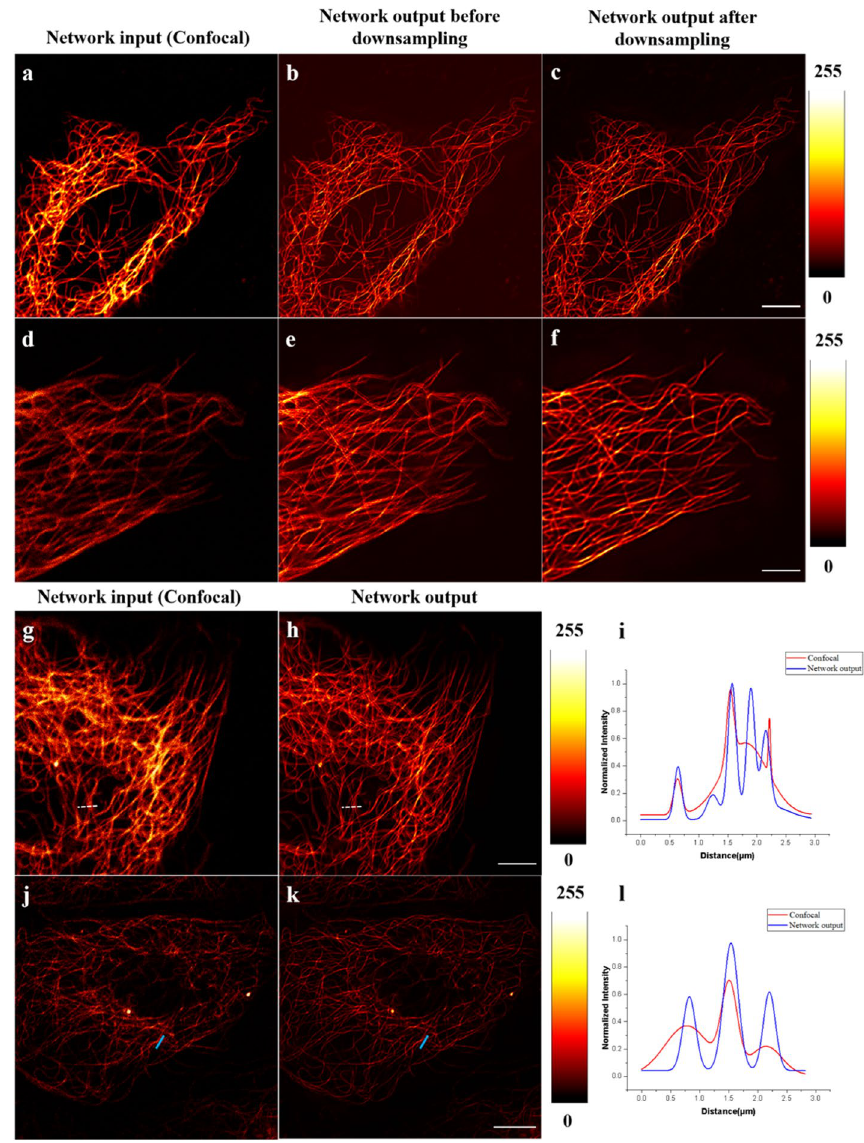
Fig. 7 Super-resolution imaging of confocal images captured with the Nikon A1R MP TCAN. ( a , d , g , j ) Diffraction-limited confocal microscopy images of the microtubules are used as input to the network. ( b , e ) The Super-resolved network inference images before downsampling the input images to match the pixel size of the training data. ( c , f ) The super-resolved network inference images after downsampling the input images to match the pixel sizes of the training data. ( h , k ) The Super-resolved network inference images without the need for downsampling the input images to match the pixel size of the training data. ( i , l ) Intensity profiles along the white dashed lines and blue solid lines in different images. Scale bar in ( c ), ( f ), ( h ) and ( k ) are 6 μm, 3 μm, 6 μm and 10 μm,